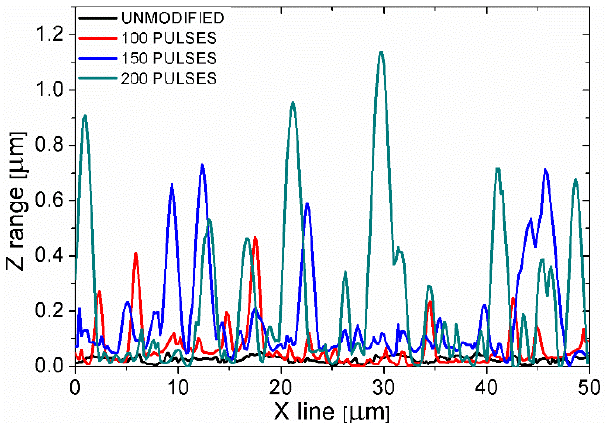
Figure 2. Cross-section profiles obtained from the AFM topographies along the selected line for unmodified PEEK and PEEK modified with 100, 150, and 200 EUV pulses, respectively.